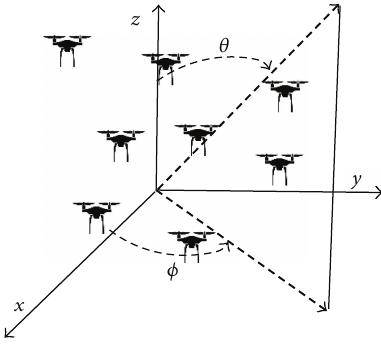
Figure 1: UAVs-based 3D antenna array with nonuniform